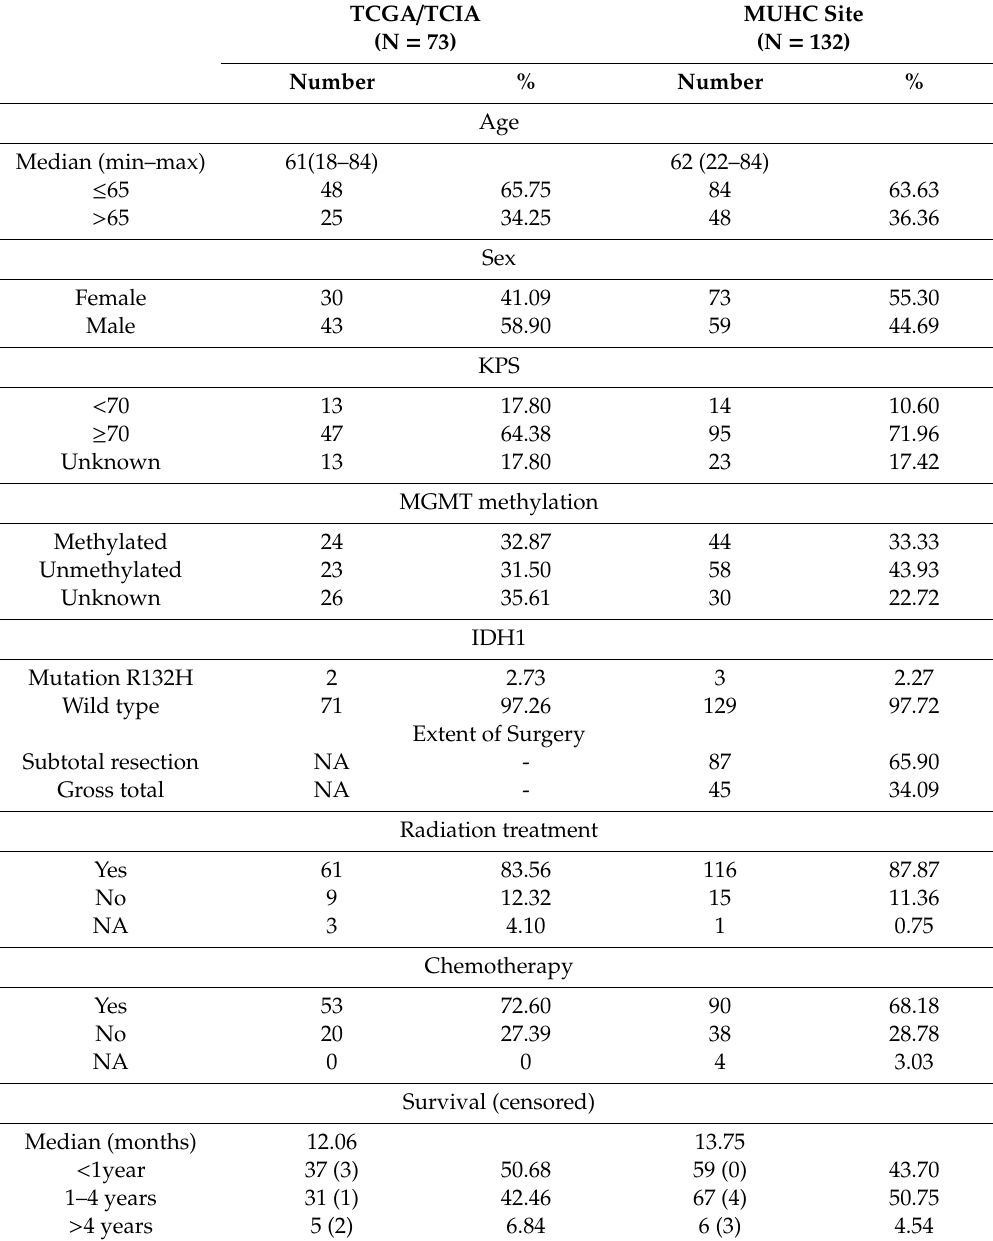
Table 1. Demographic